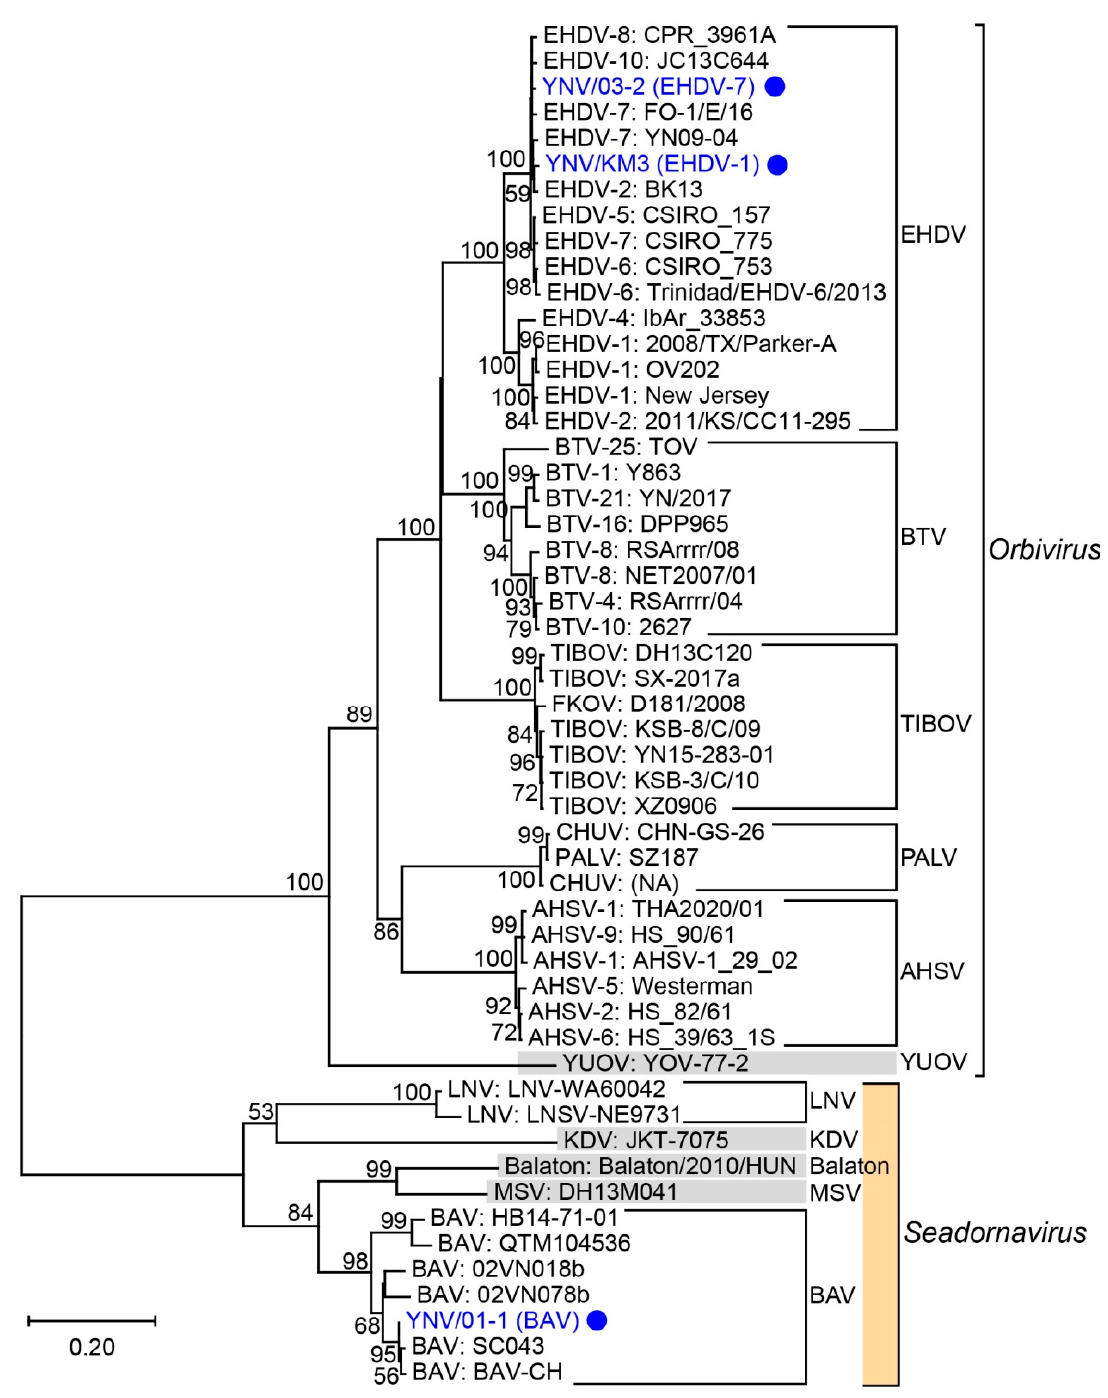
Figure 2. Phylogenetic NJ tree of representative species of Orbivirus and Seadornavirus based on VP1 (RdRP) genes. Viral species and voucher names are provided; novel isolates reported in this study are highlighted in blue circles. Bootstrap values <50% omitted.